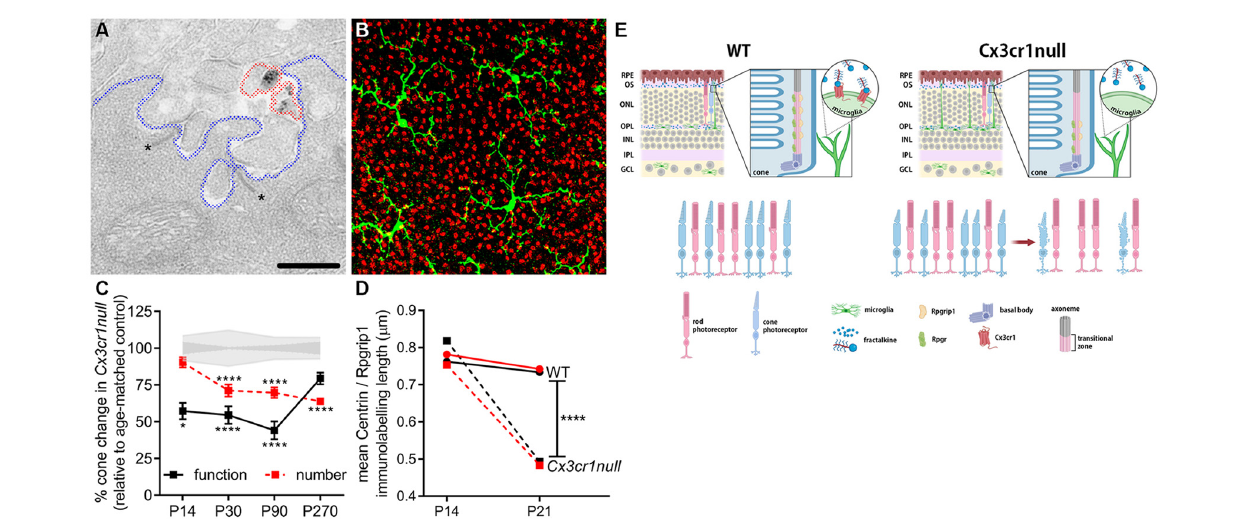
FIGURE 3 | Microglia are important in the post-natal maturation of cone photoreceptors. (A) Microglia make contact with photoreceptor synapses as shown in the electron micrograph, with Cx3cr1-EGFP-labeled microglial processes (black deposit, circled in red) in close proximity to photoreceptor ribbons (asterisk, *), within the synapse (outlined in blue). (B) Microglia (green; Iba-1) are also observed to contact multiple cone photoreceptors (red; peanut agglutinin, PNA) within the outer retina. (C) During cone photoreceptor postnatal development, function is reduced in Cx3cr1null animals from around P14 (electroretinogram, black squares), while cones are lost from 1 month of age (PNA quantification, red squares). * p < 0.05, **** p < 0.0001. (D) During outer segment elongation which occurs after eye opening ( > P14) there is a reduced length of centrin (black squares) and Rpgrip1 (red squares) expression within the cone photoreceptor cilium of the Cx3cr1null mice compared to wildtypes (circles). (E) A schematic showing that microglial communication with cone photoreceptors via the receptor Cx3cr1 is important in postnatal maturation, with loss of this receptor (Cx3cr1null) leading to restricted expression of key cilium proteins during eye opening, reduced outer segment elongation, dysfunction and ultimately cell death (Jobling et al.,